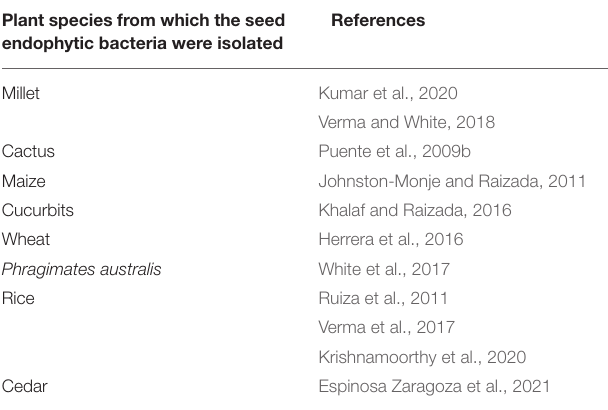
TABLE 2 | Summary table of publications recording the ability of seed endophytic bacteria of several cultivated plant species to solubilize phosphate. Plant species from which the seed endophytic bacteria were